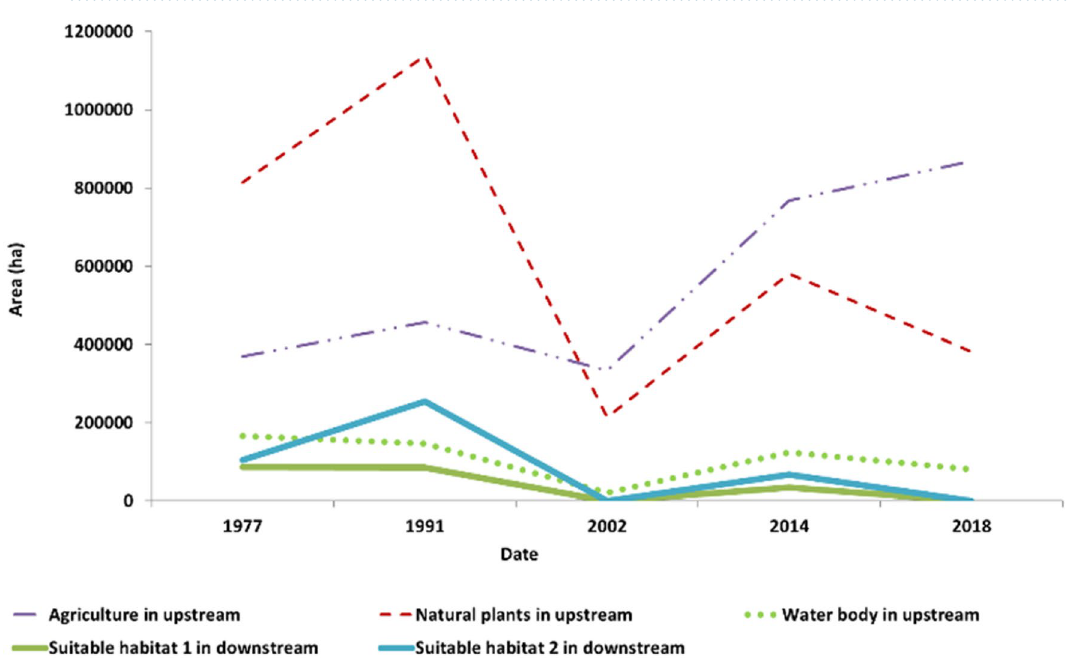
Figure 7. Comparison between the area of main land-cover classes in the upstream and suitable habitat in the